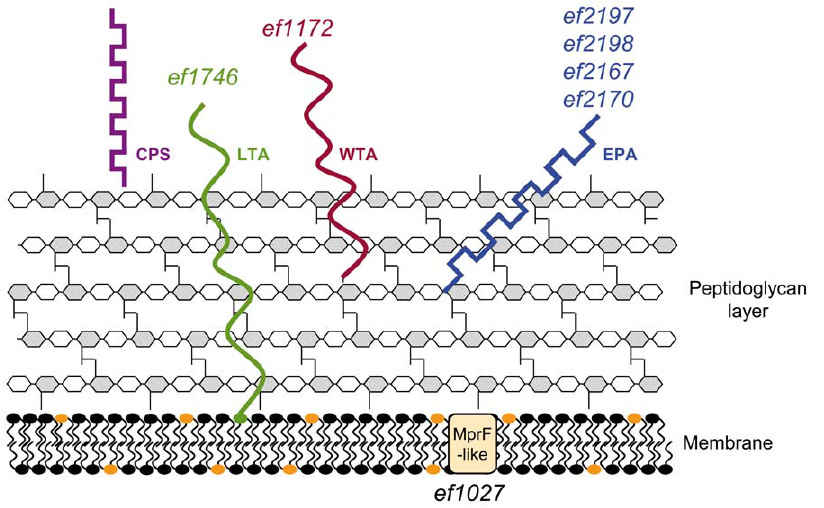
Figure 2. Schematic representation of E.faecalis V583 cell envelope, showing functions involved in pleiotropic stress protection. The E. faecalis V583 cell envelope includes the peptidoglycan-anchored teichoic acid (WTA; burgundy), the membrane-anchored lipoteichoic acid (LTA; green), the rhamnopolysaccharide (EPA; blue), and a capsular polysaccharide (CPS; purple). Names of genes predicted to participate in glycopolymer synthesis are indicated with the cognate colour code. Membrane protein MprF-like is depicted in light orange.